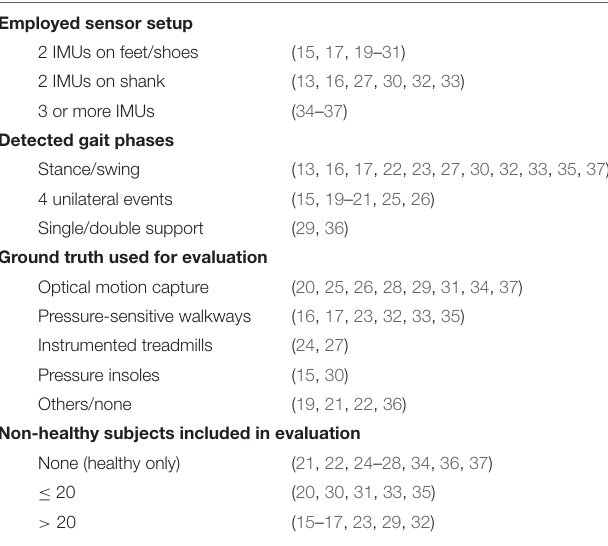
TABLE 1 | Overview of IMU-based spatiotemporal gait parameter estimation